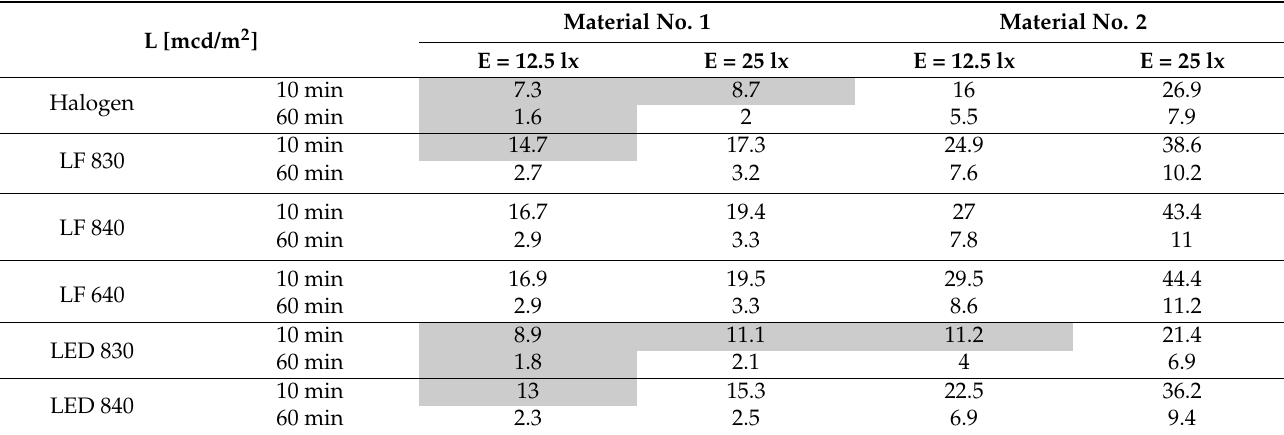
Table 2. The luminance values measured 10 and 60 min after the disappearance of the excitation source (values that do not meet the requirements [2] have been marked by background grey colour). Material No. 1 L [mcd/m 2 ]